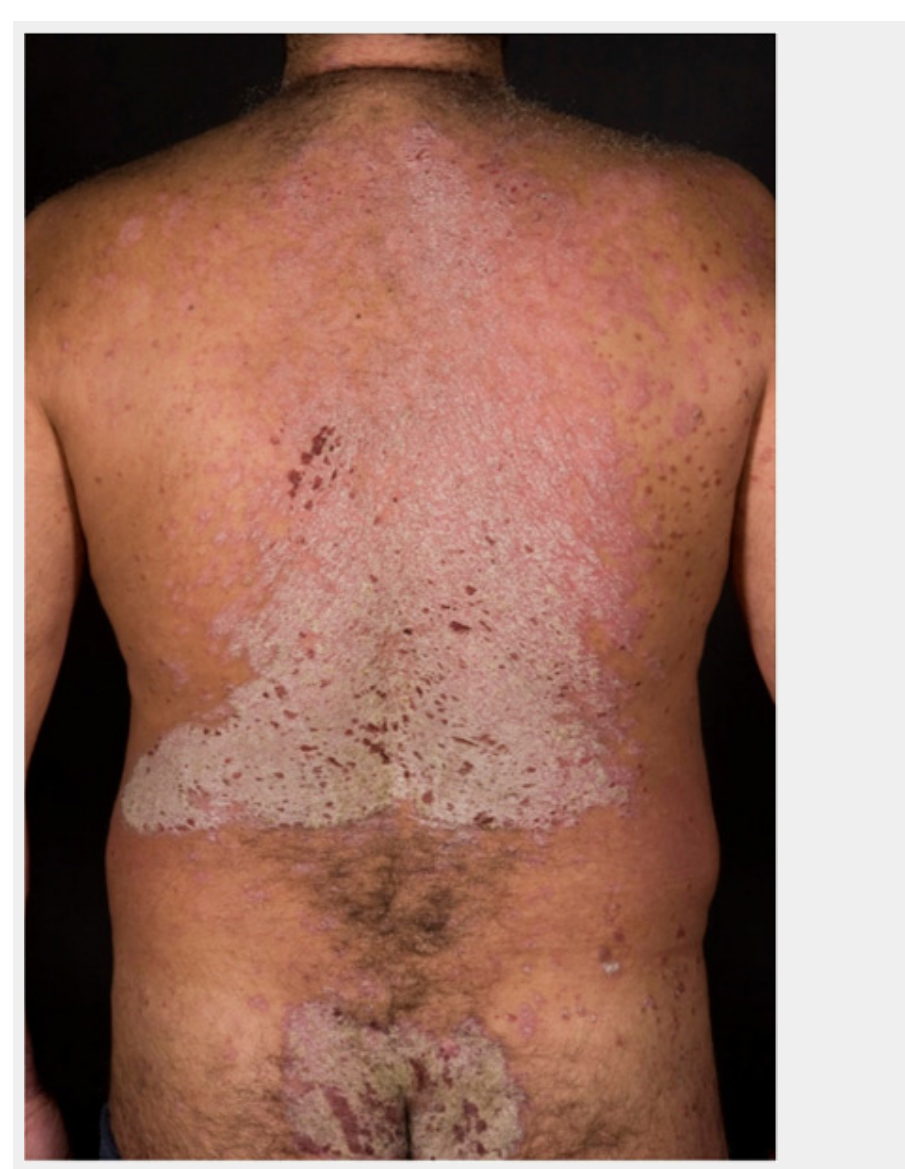
Figure 1 Chronic plaque-type psoriasis. This classical clinical manifestation of psoriasis is characterised by well demarkated, red, infiltrated plaques, covered with a coarse silvery scaling. Here, the lumbar region as a predilection site is